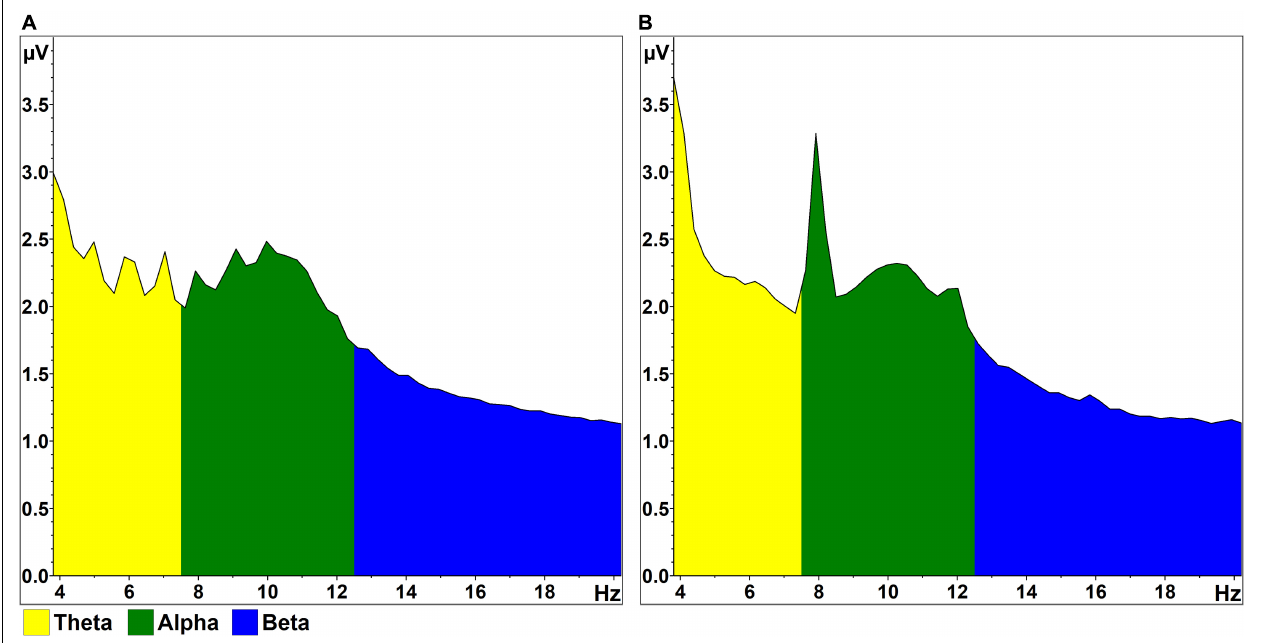
FIGURE 2 | RSVP FFT output. (A) Mean FFT magnitude (normalized amplitude; pooled occipitoparietal sites), averaged across all 1,000 stimulus epochs in the 1 Hz condition and across all participants. A peak is visible at 10 Hz, within the range of alpha activity. (B) Similar FFT data, generated from the 4 Hz condition. Again, a peak is visible at 10 Hz, bookended by sharper peaks reflective of the 2nd (8 Hz) and 3rd (12 Hz) harmonics of the SSVEP, which results from high-contrast flickering (4 Hz) in the letter